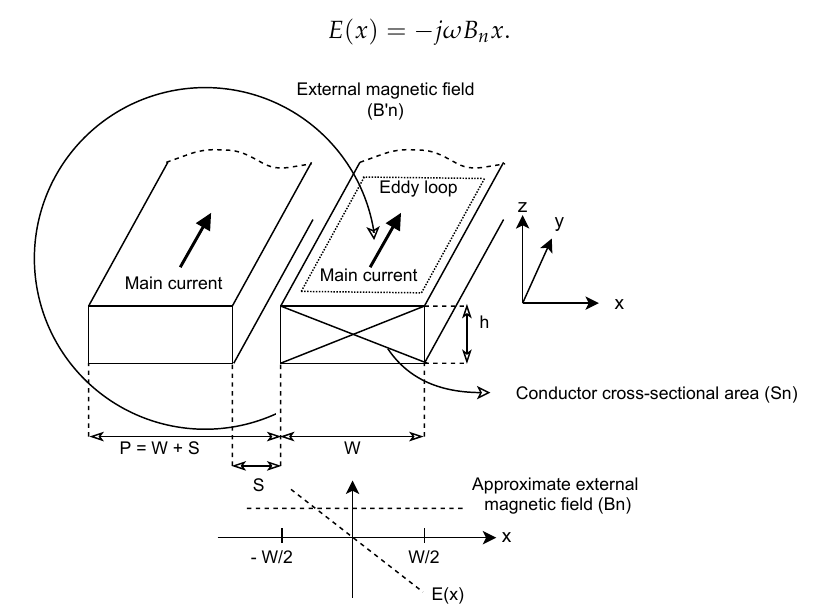
Figure 5. The copper track under external